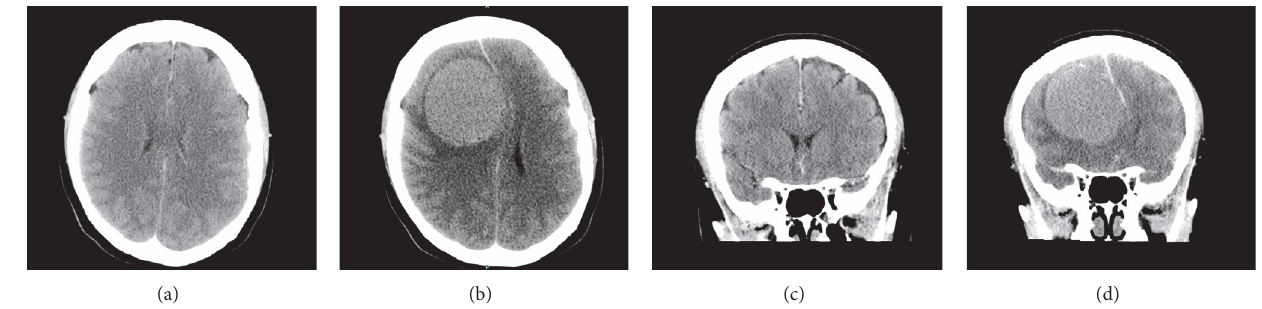
Figure1:CTscanofthepatient,displayingtherapidrateofgrowthofthemeningioma:(a)axialviewDecember2012;(b)axialviewDecember 2014; (c) coronal view 2012; (d) coronal view 2014.